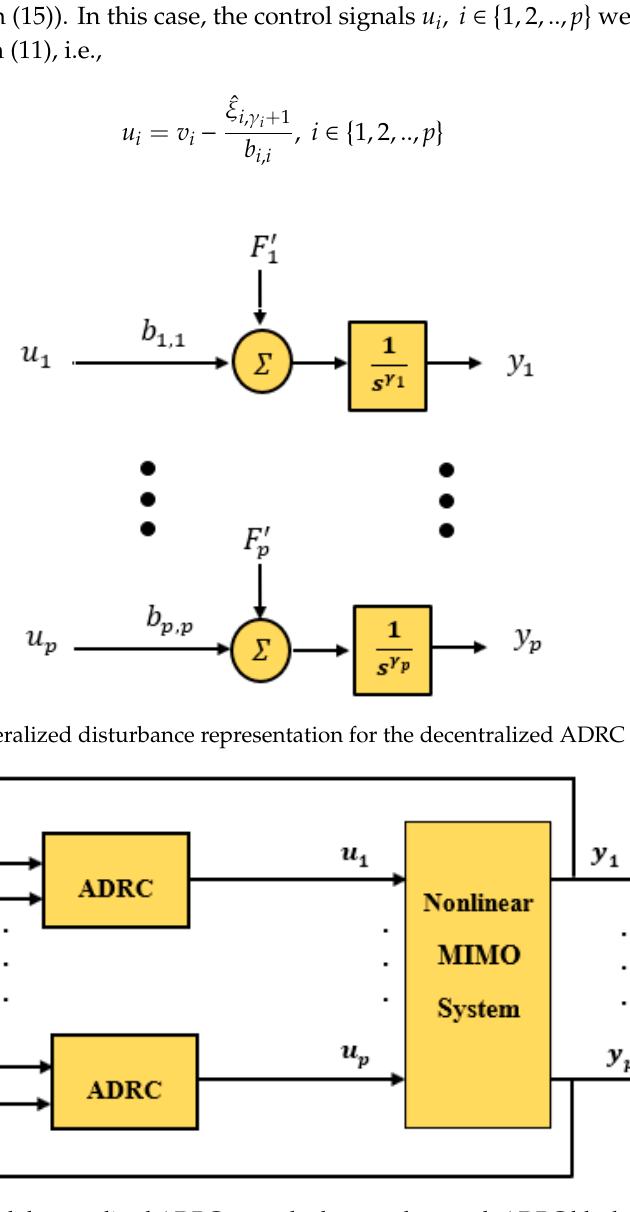
Figure 5. The proposed decentralized ADRC control scheme, where each ADRC block involves a SISO connection of TD, NLSEF, and ESO, as in Figure 1.